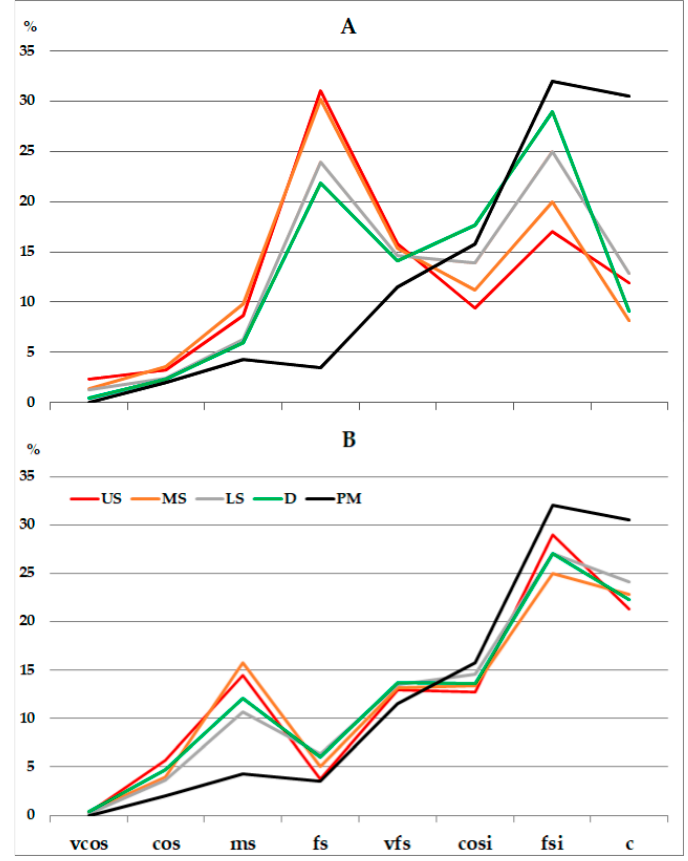
Figure 3 . Histogram of PSD in humus horizons and parent materials in moraine ( A ) and ice-dammed lakes ( B ) landscapes. Explanations: US—upper slope, MD—middle slope, LM—lower slope, D—depression, PM—parent material; g—gravel, vcos—very coarse sand, cos—coarse sand, ms—medium sand, fs—fine sand, vfs—very fine sand, cosi—coarse silt, fsi—fine silt, c—clay.